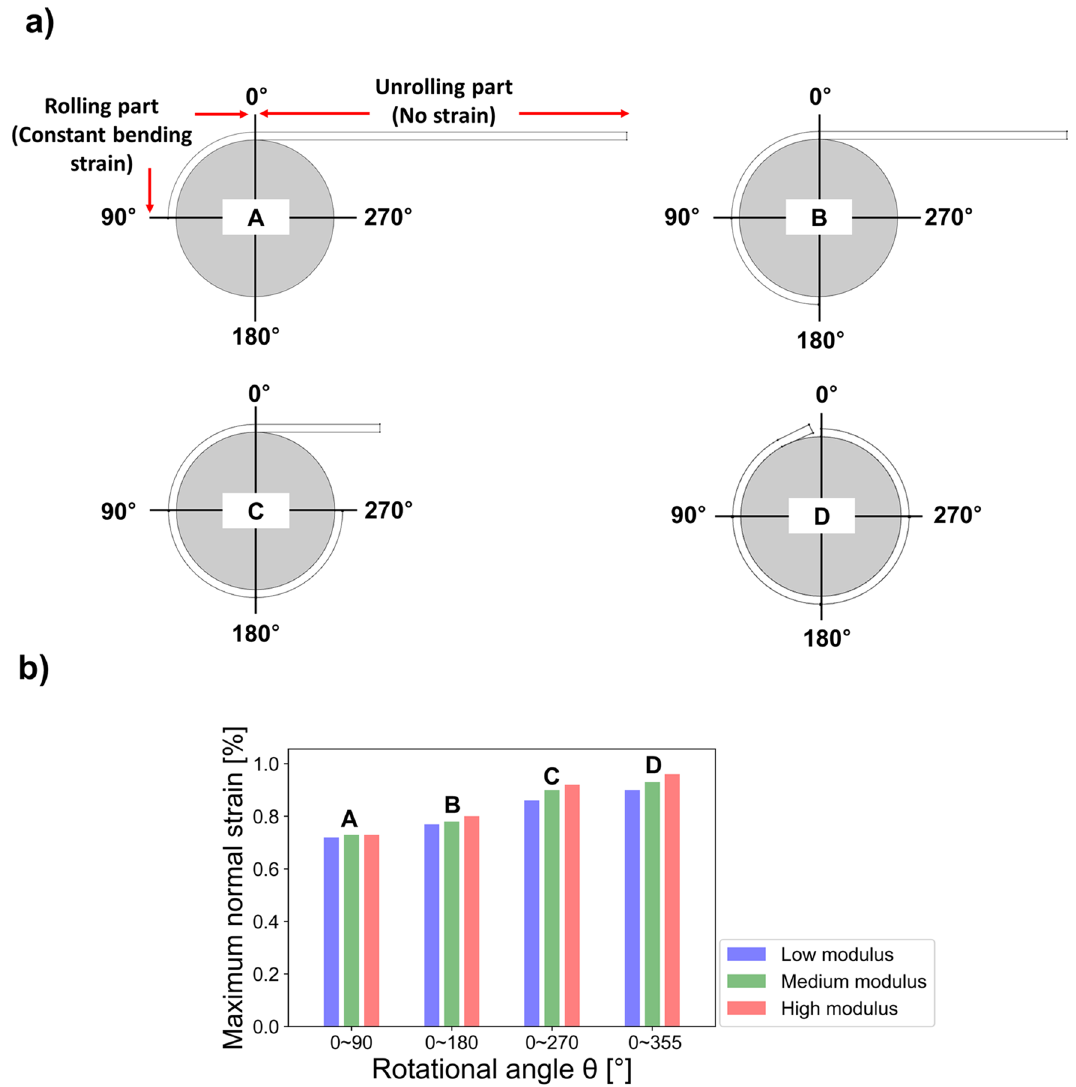
Figure 3. ( a ) Rigid functional layers with respect to the rolling deformations of 90°(A), 180°(B), 270°(C), and 360°(D). ( b ) Maximum normal strain results according to the rotation angle of rolling deformation based on the use of OCA materials with different